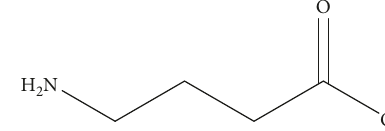
Figure 2: Structure of c -aminobutyric